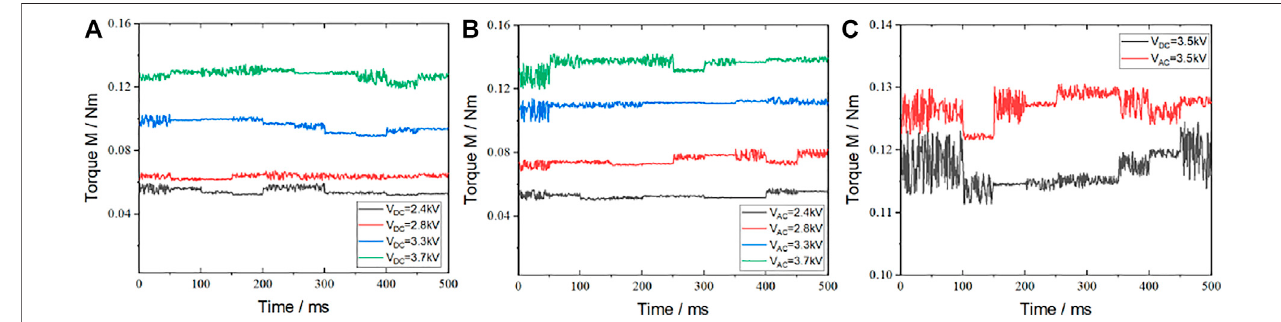
FIGURE 9 | The output torque curves of ERF transmission with the fl at-corrugated disk. (A) Output torque under DC (B) Output torque under AC (C) the comparison of DC&AC.